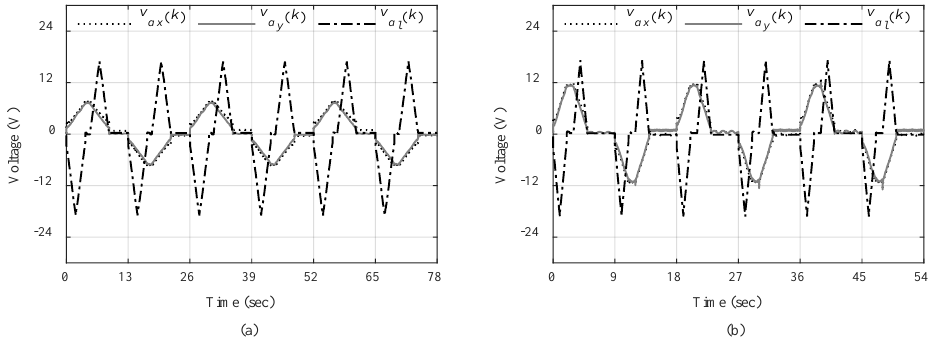
Figure 9. Control input voltages: ( a ) Slow trajectory; ( b ) Fast trajectory.